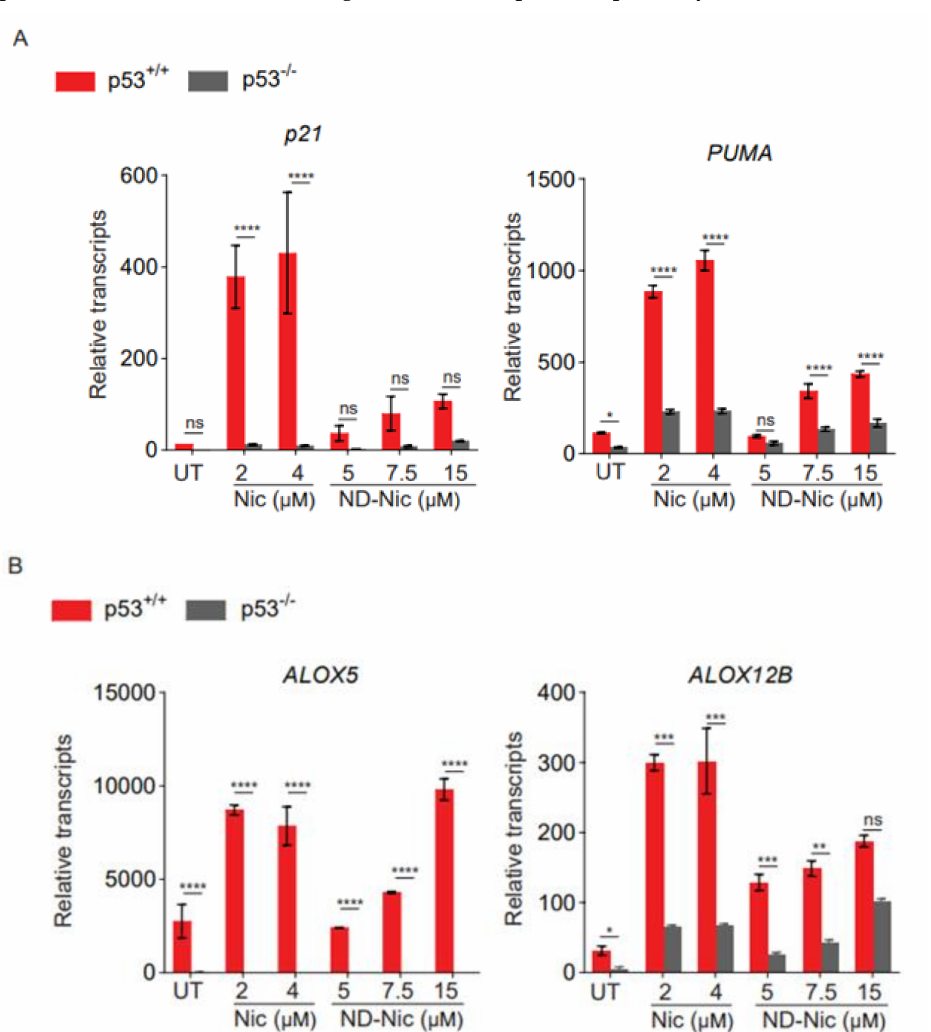
Figure 6. Nitro-deficient niclosamide induces p53 dependent upregulation of Alox5 and Alox12B . Relative transcript level of ( A ) p21 and PUMA and ( B ) Alox5 and Alox12B assessed by qPCR in human colon carcinoma HCT116 p53 +/+ and p53 − / − cells, untreated (UT) or treated with Nic (2 and 4 µ M) and ND-Nic (5, 7.5, and 15 µ M) for 48 h. Error bars represent ± SD of at least 3 independent experiments. t -test was used to determine significance (*, p < 0.05; **, p < 0.01; ***, p < 0.001; ****, p < 0.0001; ns, p >